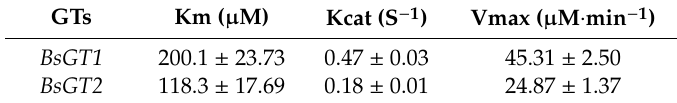
Table 1. Kinetic parameters of BsGT1 and BsGT2 toward curcumin. GTs: glycosyltransferases.